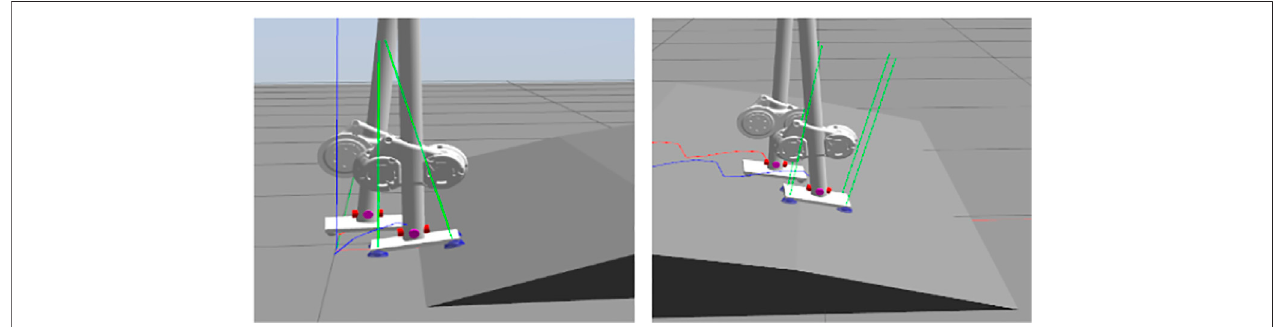
FIGURE 7 | With the whole body controller, the foot is compliant, and the robot can perform transitions to different terrains even though the robot does not know how the terrain looks like. This makes the robot robust to unobserved terrain variations. The green lines indicate the magnitude and direction of the ground reaction forces. The blue and red lines show the trace of the right and left foot centers, respectively.